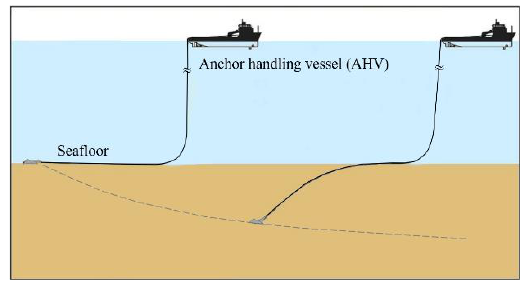
Figure 1. The trajectory of a drag anchor during installation [1].